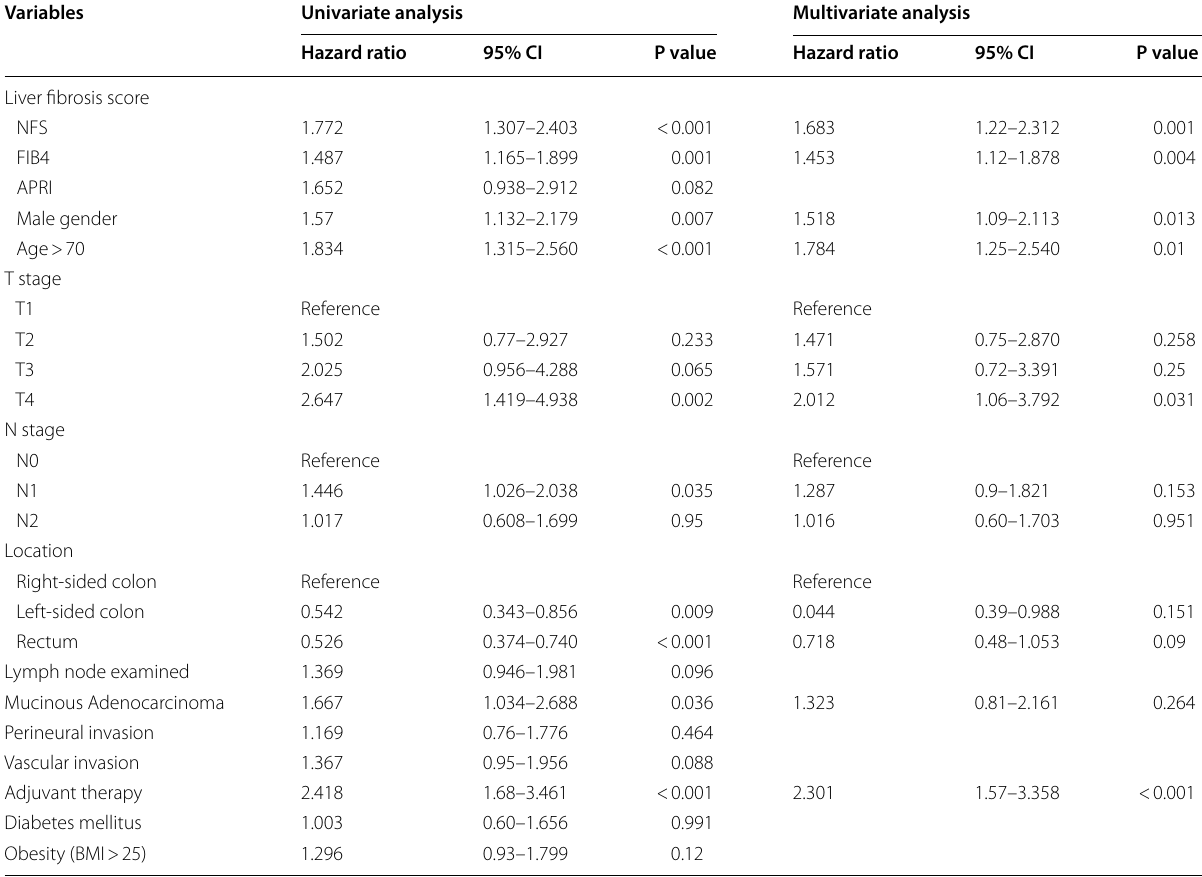
Table 4 Risk factors for over-all survival